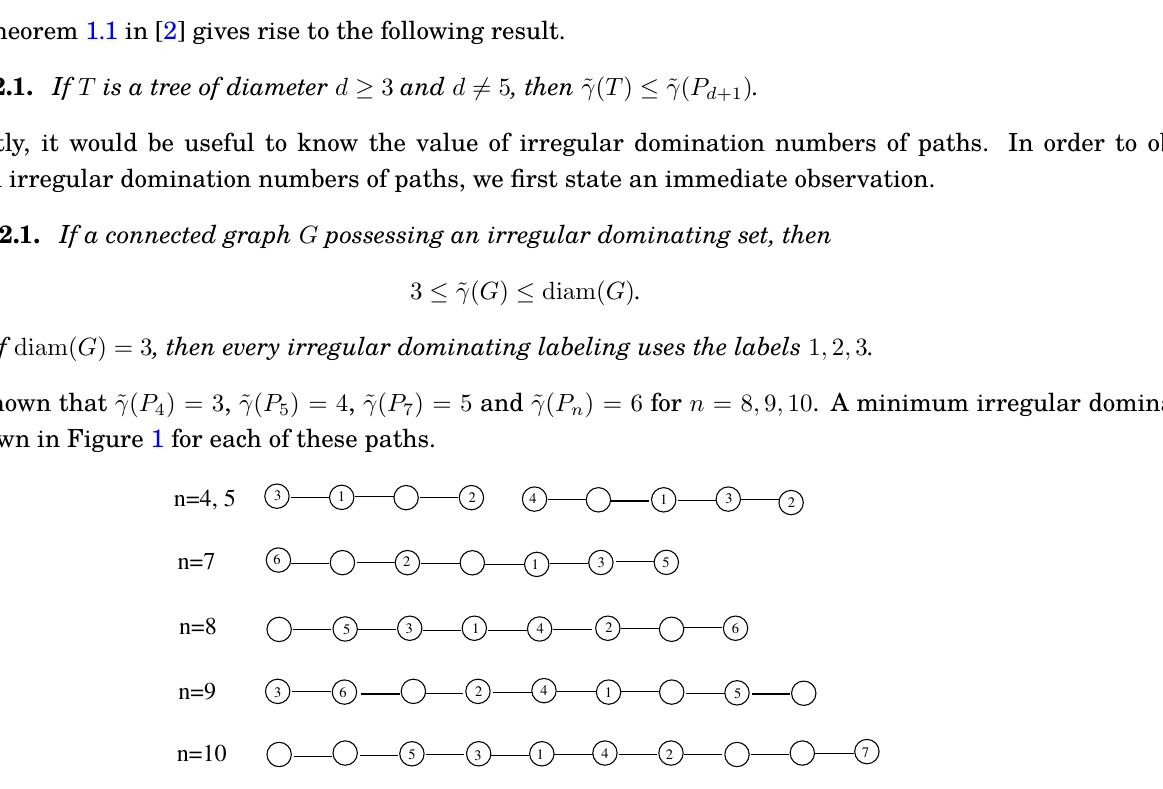
for n = 4 , 5 , 7 , 8 , 9 , 10 n